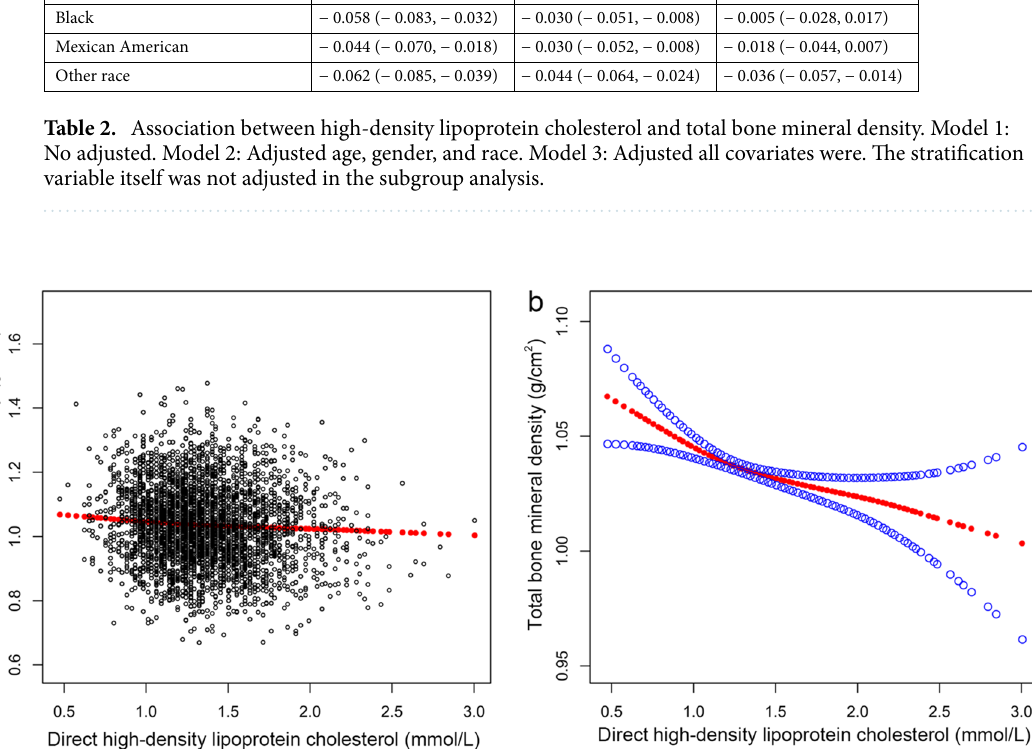
Figure 2. The expounded curved line correlation between the level of HDL-C and total BMD. ( a ) One black point was equal to a subject. ( b ) A 95% CI is expressed as an area between two blue dotted lines. Each point shows HDL-C magnitude, and a continuous line is